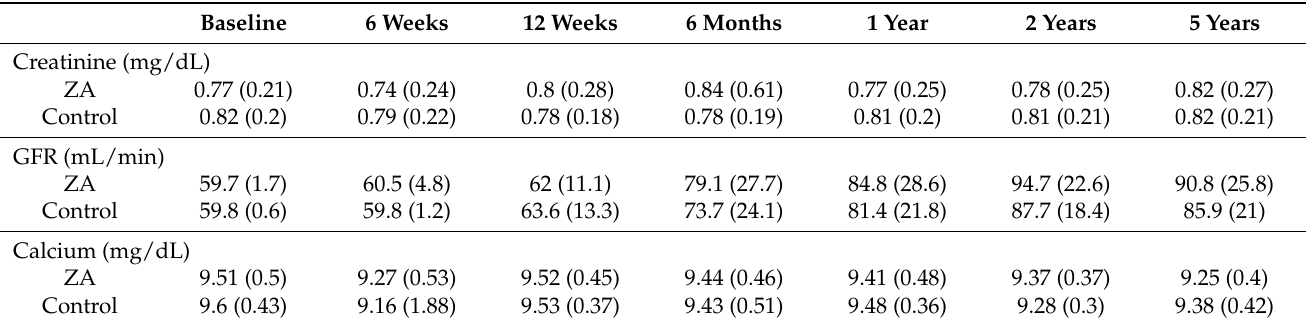
Table 2. Comparison of serum biomarkers between ZA ( n = 25) and control ( n =